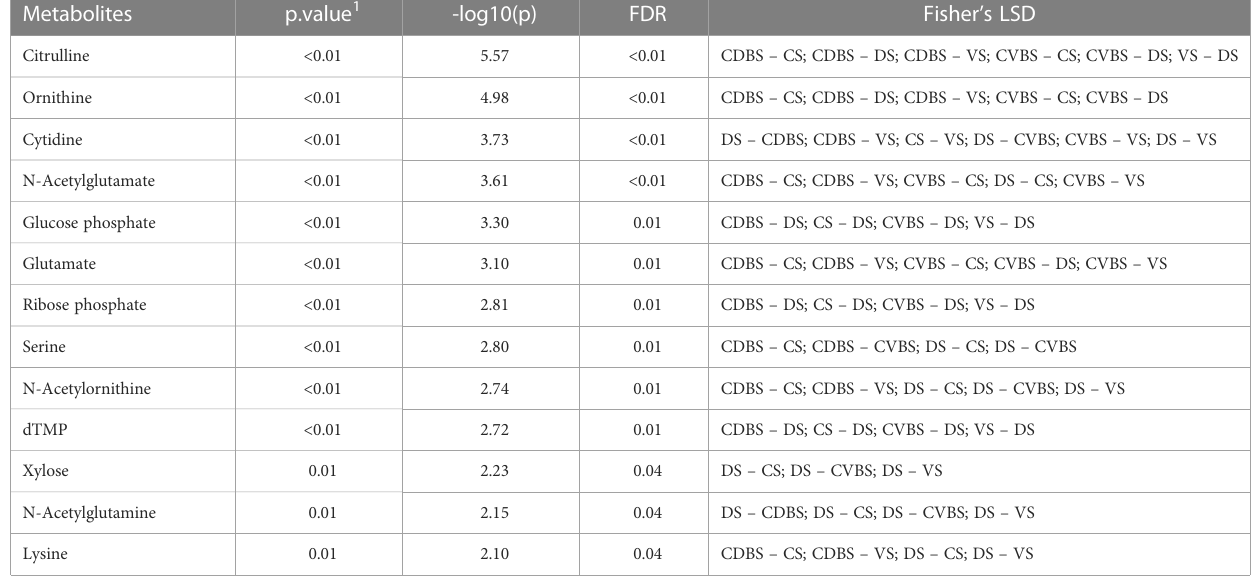
TABLE 1 Metabolite differences among the fi ve rumen sacs.